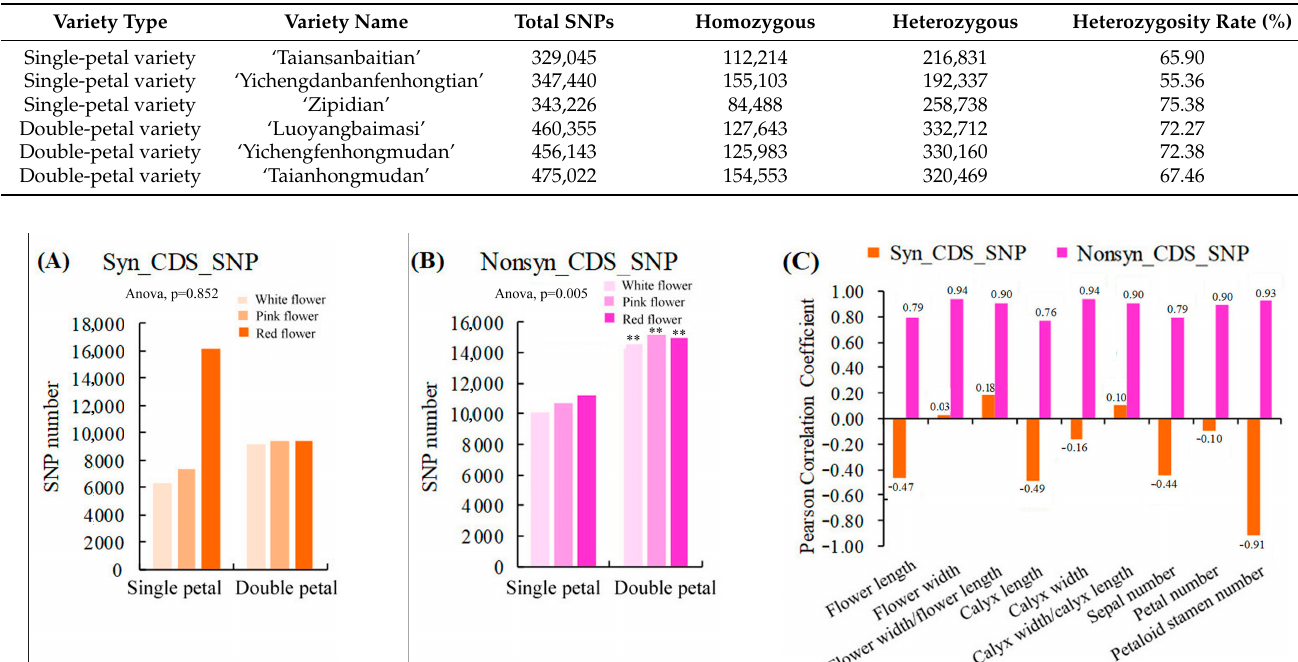
Table 3. SNPs statistics of six ornamental pomegranate varieties.